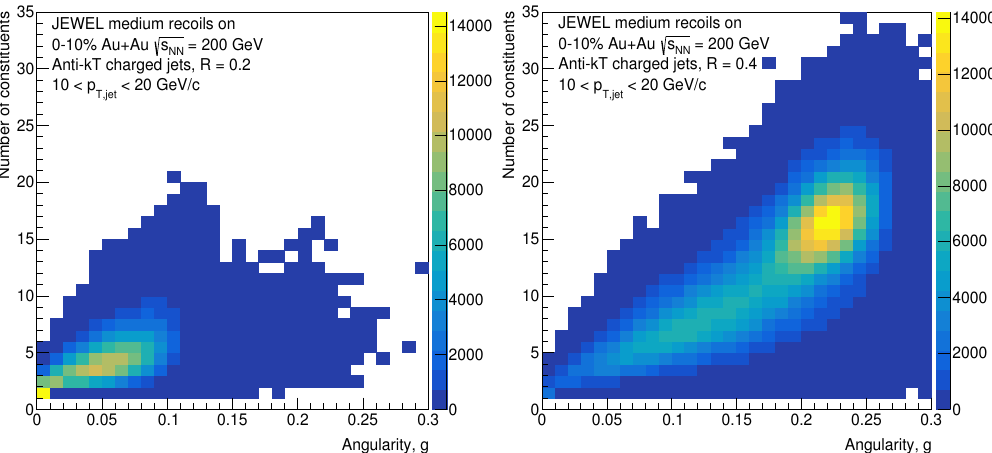
Figure 5. 2D statistics for jets with p T of 10–20 GeV/ c and R = 0.2 ( left ) and R = 0.4 ( right ) in central √ s NN = 200 GeV simulated with “recoils on” Au+Au collisions at